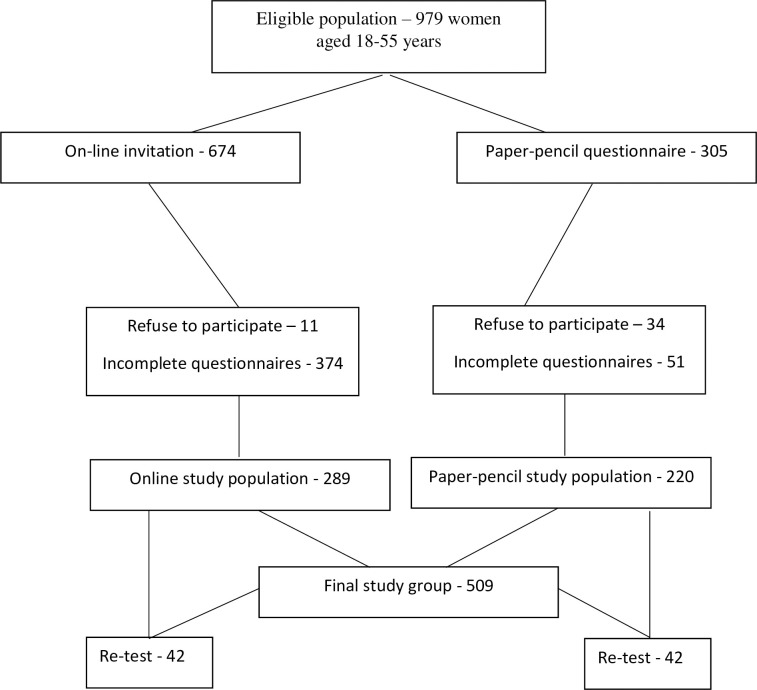
Study chart: Enrollment protocol.